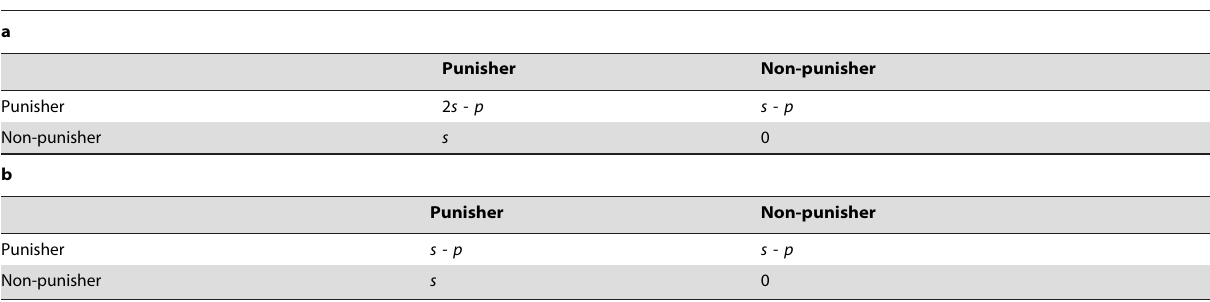
Table 1. Whether or not to punish a